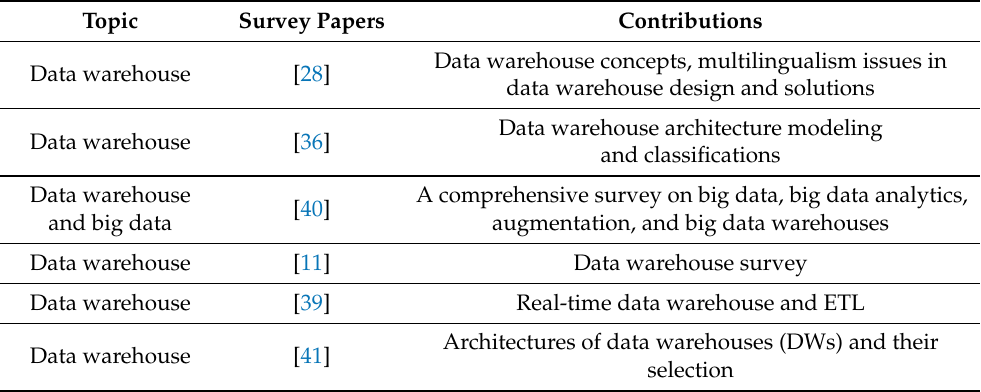
Table 2. Summary of existing survey articles on data warehouses and data